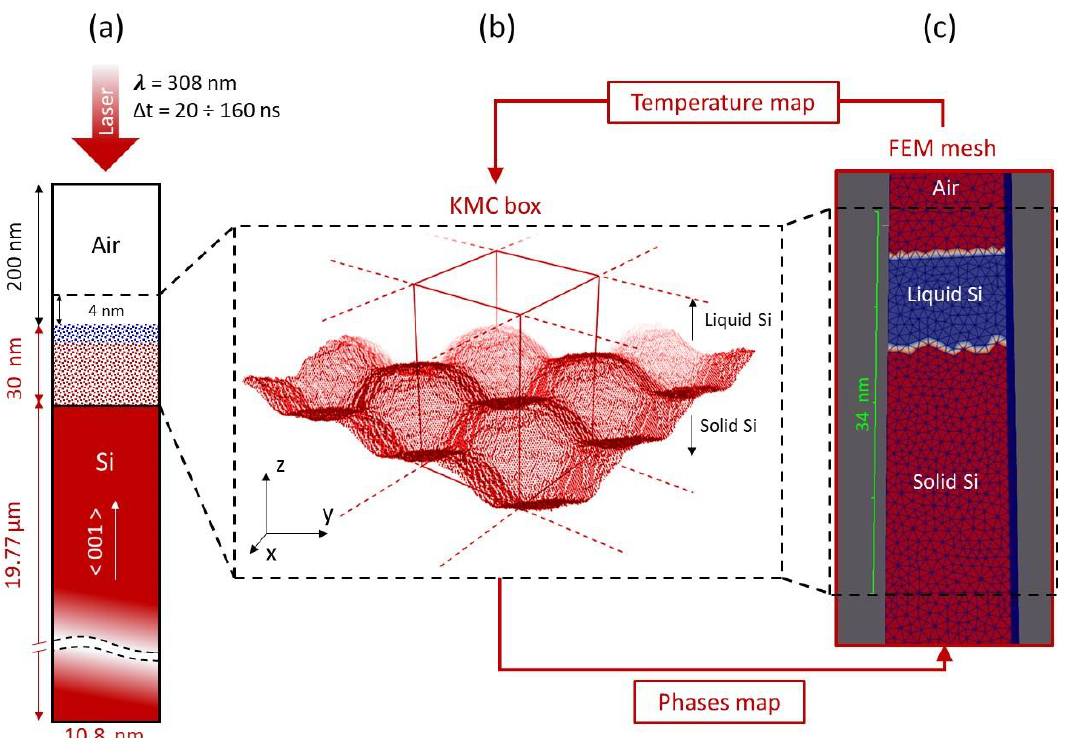
Figure 11. Schematics and validation of the multiscale FEM-KMC method for PLA simulations. ( a ) Outline of input FEM geometry for Si(001), with dotted area indicating the sub-system modeled with KMC (blue: liquid Si volume; red: solid Si volume). ( b ) KMC box, containing the solid–liquid front evolving during irradiation (green: under-coordinated solid Si atoms). ( c ) Sub-region in FEM mesh coupled with KMC (blue: liquid Si volume; red: solid/air volumes).